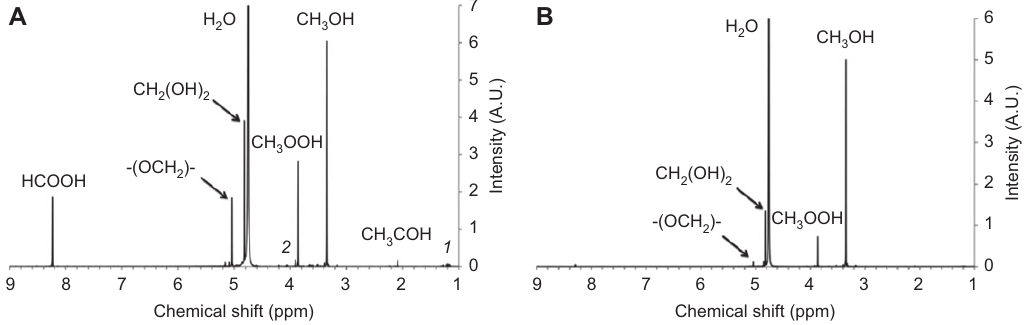
= O ; 20 cm 3 /min, distilled water 4 2